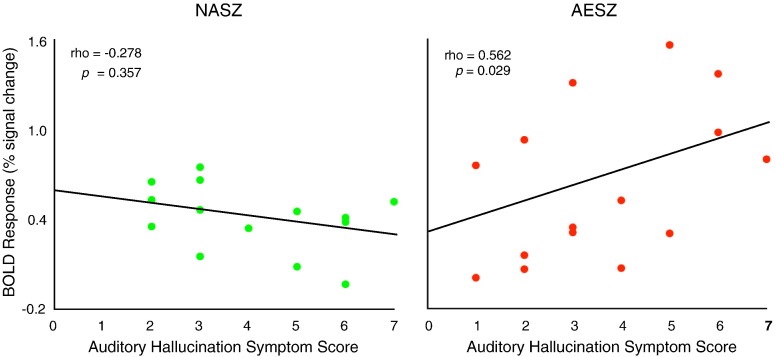
Correlations between auditory hallucination symptom scores and BOLD percent signal change in the left auditory cortex during 80-Hz stimulation in patients with NASZ (left) and AESZ (right). Although we used Spearman's rho to test statistical significance due to the small N, we have also plotted a least squares line for the convenience of the reader.